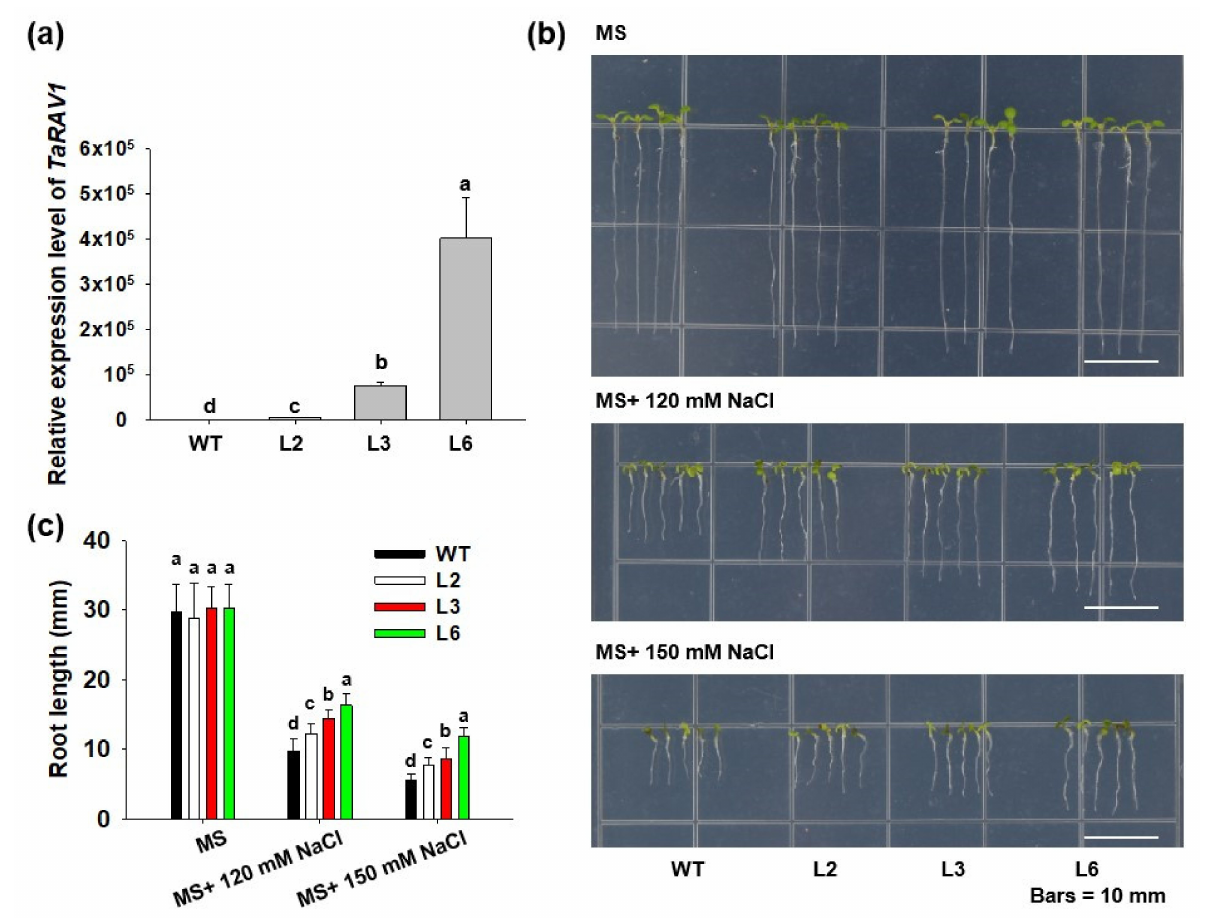
Figure 6. Effect of overexpressing TaRAV1 on Arabidopsis salt tolerance. ( a ), TaRAV1 expression level in wild-type (WT) and 3 selected transgenic lines (L2, L3, L6). Seedlings grown on MS media for 14 days were collected for RNA extraction. Transcript levels of TaRAV1 were quantified using the qRT-PCR method and normalized to that of Atactin . The level of WT is set to 1. Data shown are means ± SE (n = 3). ( b ), Root elongation of WT and transgenic seedlings on MS agar media. WT and TaRAV1 transgenic seeds were germinated on MS media, and 6-day-old seedlings were transferred to MS media or MS media containing 120 or 150 mM NaCl (MS + 120 or 150 mM NaCl). Plates were cultured vertically for 8 days before measuring root length. Scale bars, 10 mm. ( c ), Measurement of root length of the seedlings shown in b. Data shown are means ± SE (n ≥ 40). Different